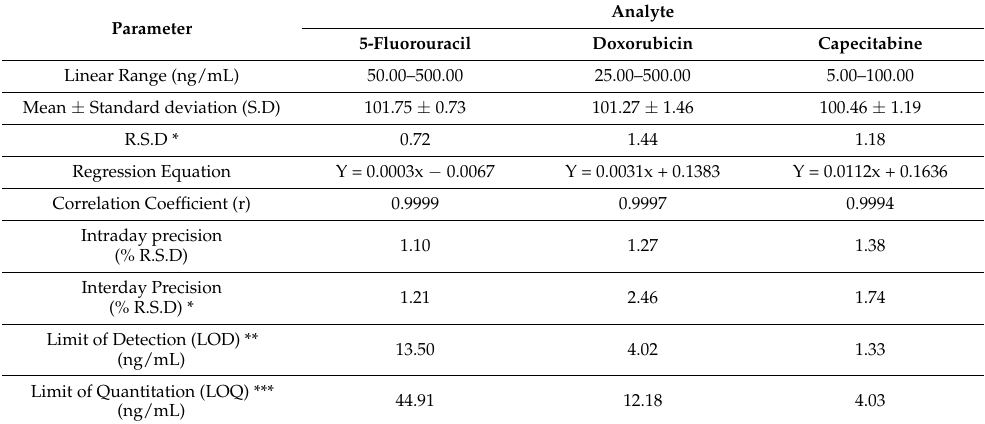
Figure 5. Effect of clean-up step on the extraction efficiency of the compounds from spiked rat plasma using different solvents, amounts of acetonitrile, PSA, and MgSO 4 . ( a ) Effect of type of solvent, ( b ) Effect of volume of acetonitrile, ( c ) Effect of amount of MgSO 4 , ( d ) Effect of amount of PSA. Table 2. Validation parameters of the proposed method for the investigated analytes in rat